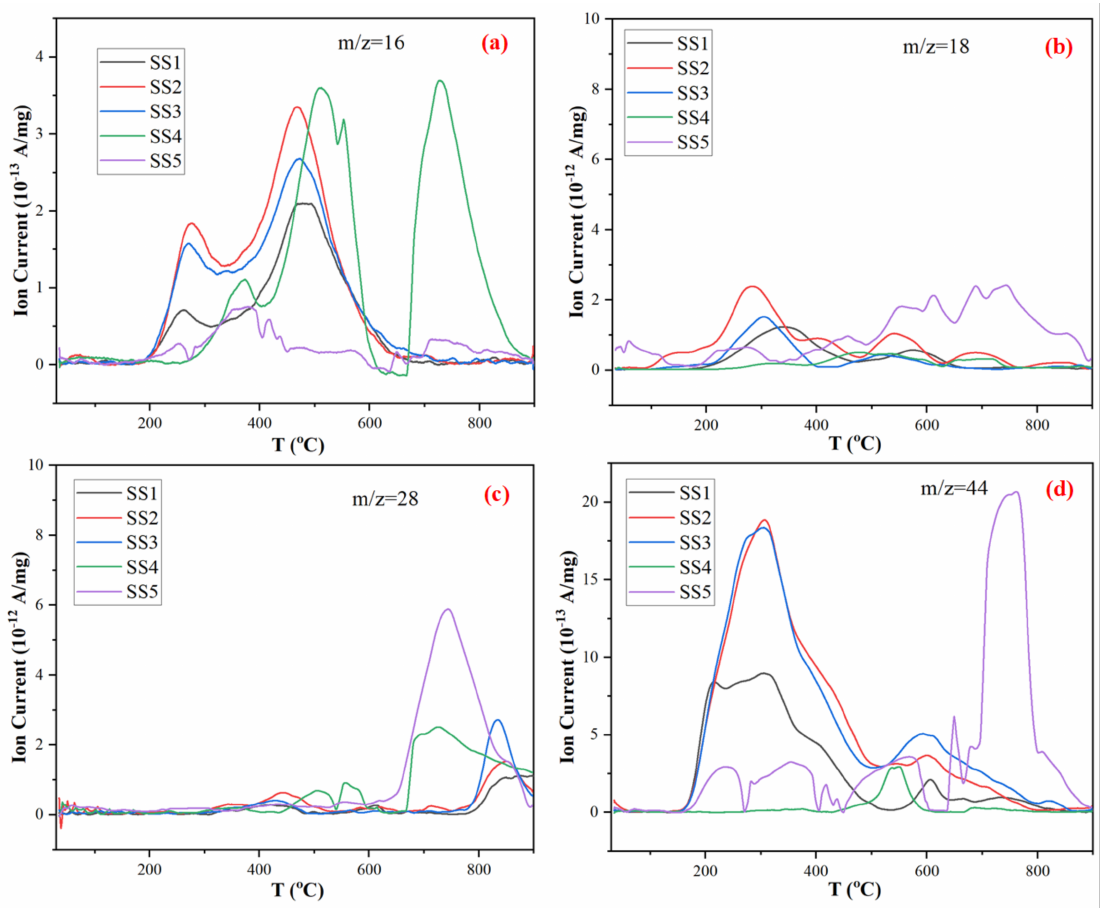
Figure 6. Ion content of some specific gas fragments along with temperatures ( a ) m / z = 16; ( b ) m / z = 18; ( c ) m / z = 28; ( d ) m / z =